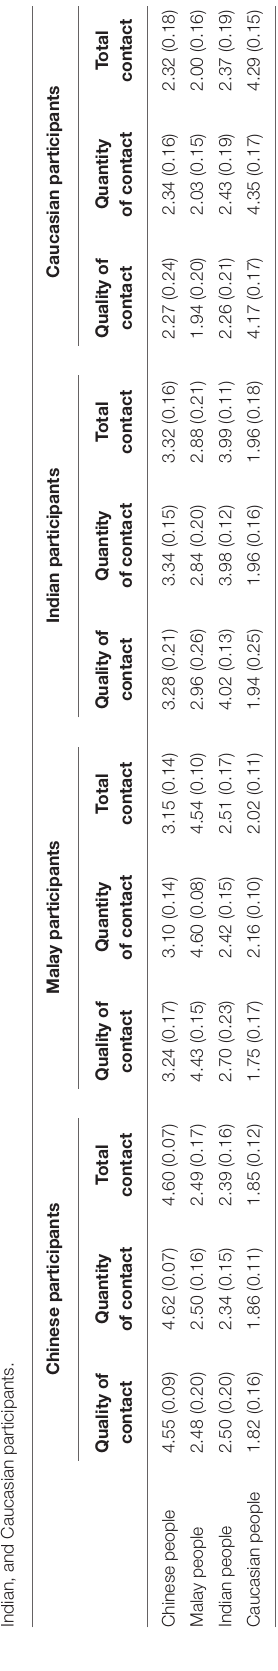
( p = 0.005) and Caucasian ( p = 0.03) faces. Malay